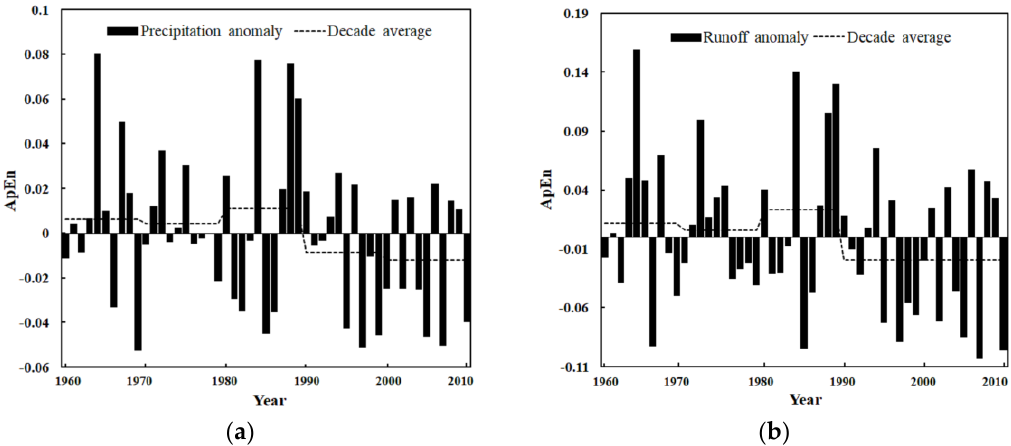
Figure2. The annual approximate entropy (ApEn) of precipitation ( a ) and runoff( b ) with the Figure 2. The annual approximate entropy (ApEn) of precipitation ( a ) and runoff ( b ) with the differences of their decadal mean values in the Jing River Basin. differences of their decadal mean values in the Jing River